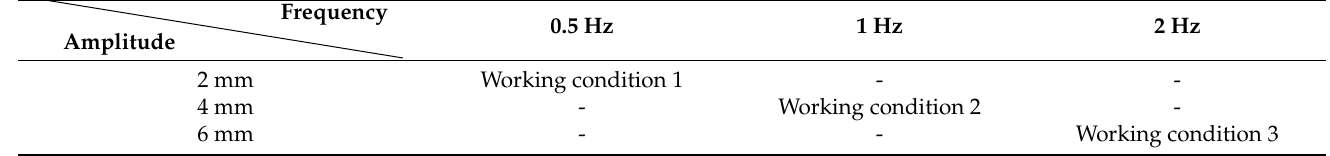
Figure 10. Updated schematic diagram of the HDU position control system. Table 3. Working conditions in